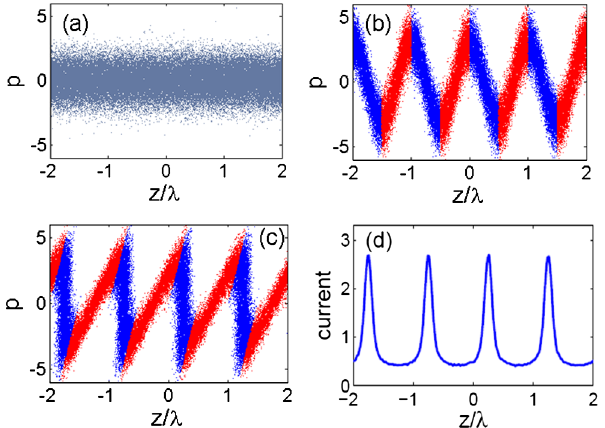
chicane.FIG. 1. Evolution of the longitudinal phase space in HGHG scheme: (a) before the modulator; (b) after the modulator; (c)